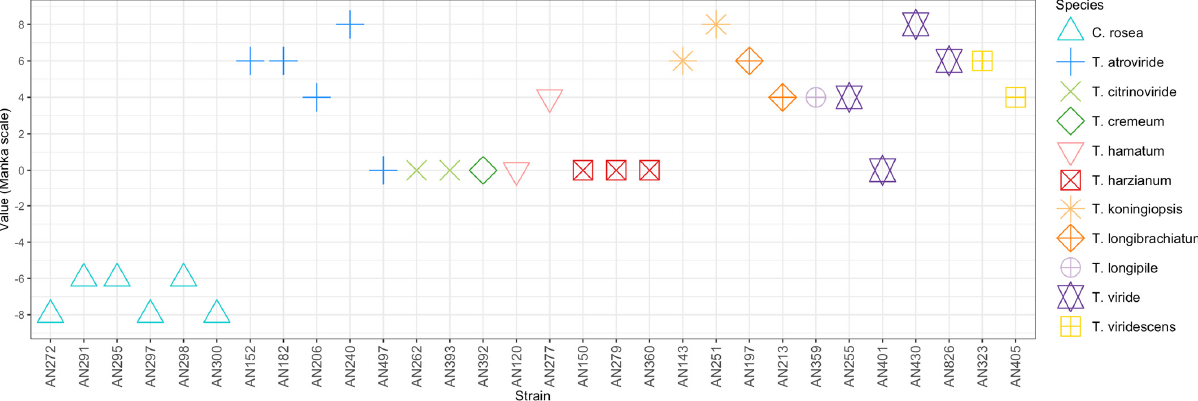
Figure 3. The qualitative evaluation of the F. culmorum KF846 —Clonostachys and F. culmorum KF846 —Trichoderma interaction after 14 days of co-incubation on PDA medium by using modified Ma´nka [36]. The symbol represents a median of three replications.